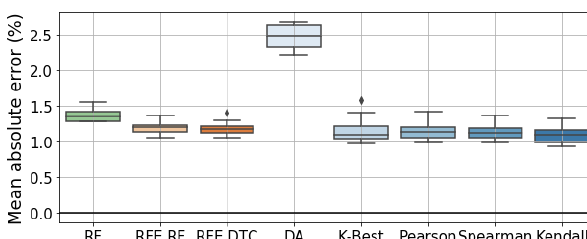
Figure 7. Mean absolute error of every feature selection method’s ANNs as a percentage of the maximal DEL value. RFE stands for recursive feature elimination, RF for random forest, DTC for deci- sion tree classifier and DA for dominance analysis.